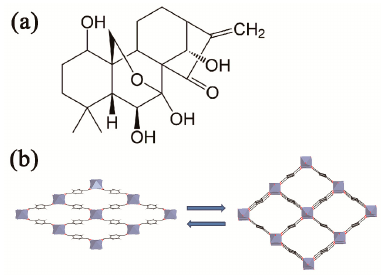
Figure 1. Structural Diagram. ( a ) chemical Structure of Ori and ( b ) respiratory effect on the mutual conversion of large and small pore of MIL-53(Fe).